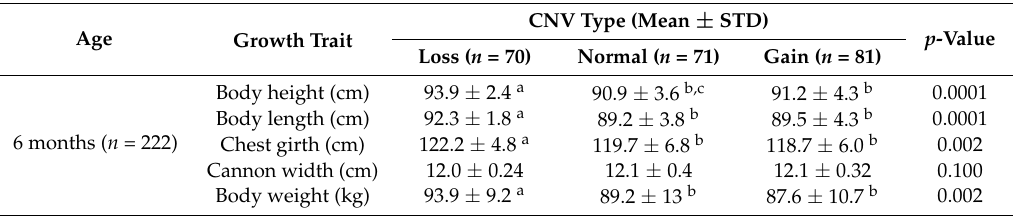
Table 2. Analysis of the association between copy number variations (CNVs) in the KLF6 gene and growth traits in Datong yak